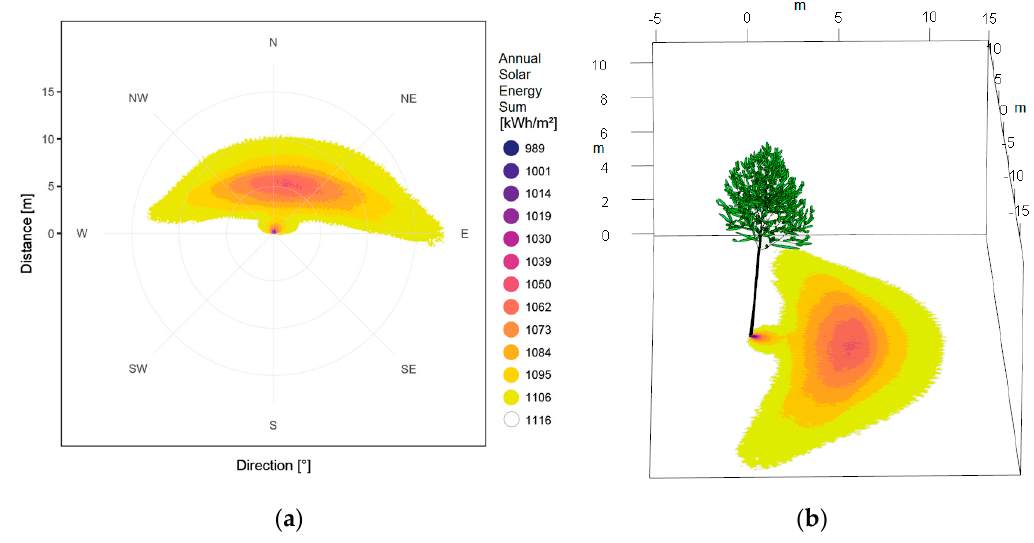
Figure 5. ( a ) Annual solar radiation distribution below the model tree along the compass directions, the outer circle representing a radius of 15 m around the tree stem; ( b ) the 3D visualization of the tree model with the annual solar radiation distribution.